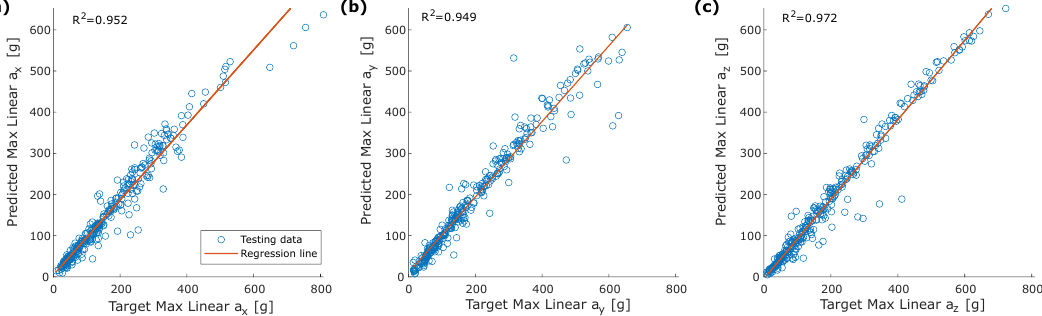
Figure 6. Correlation between target and predicted peak linear acceleration: ( a ) a x ; ( b ) a y ; ( c ) a z